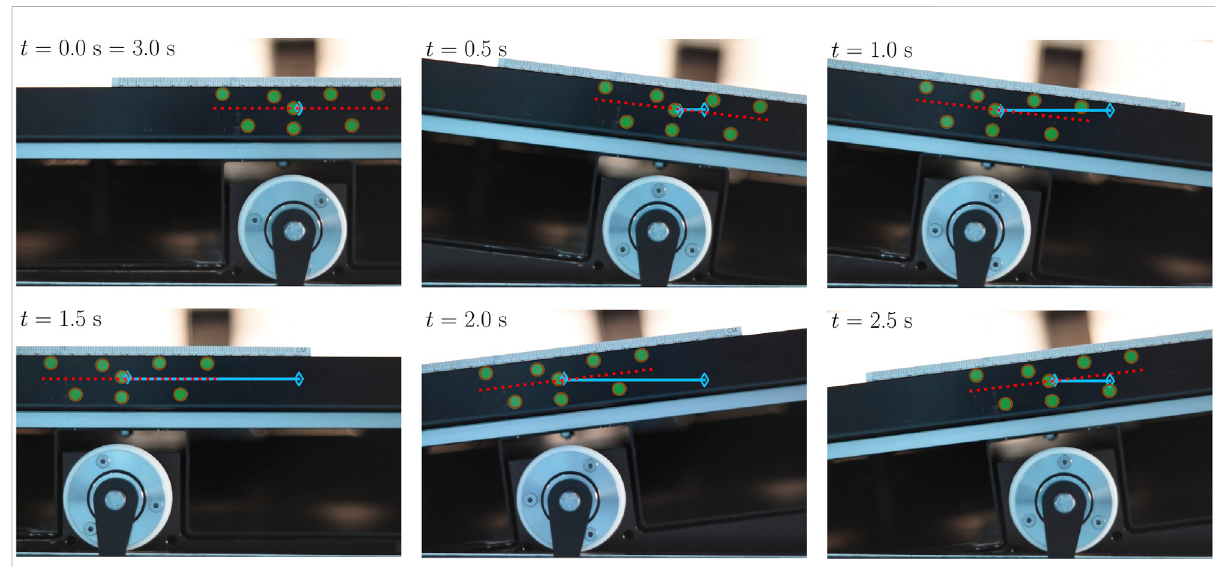
FIGURE 2 ThetimeseriesshowstheCELL-tainermovementoveroneperiod(3 s)insiximagesatarockingrateof20 rpmandasetangleof8.2 ° .Inbrown, therespectivecircledetections via theHoughtransformationareshown(detectionofthegreenmarkers).Theredlineshowsthecalculatedrotation, and the blue line indicates the relative translation to t = 0, whereby the empty diamond marks the initial position.